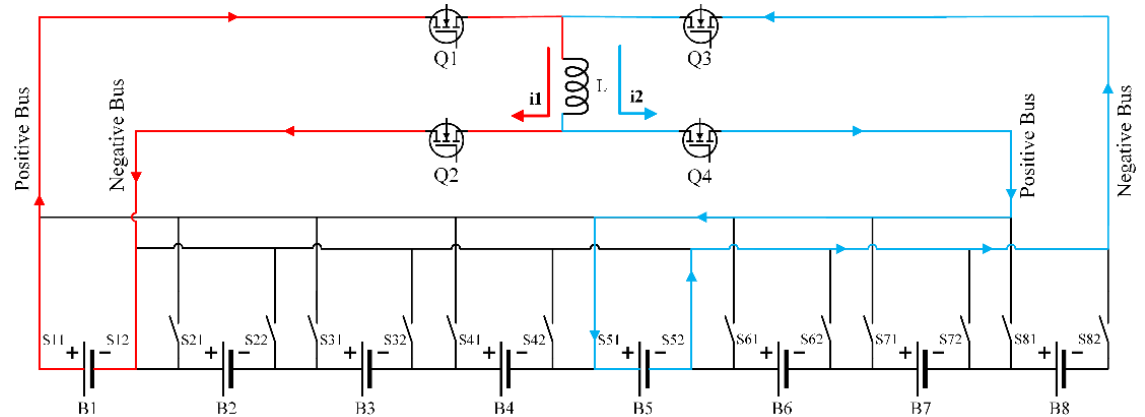
Figure 2. Any-cell-to-any-cell balancing.